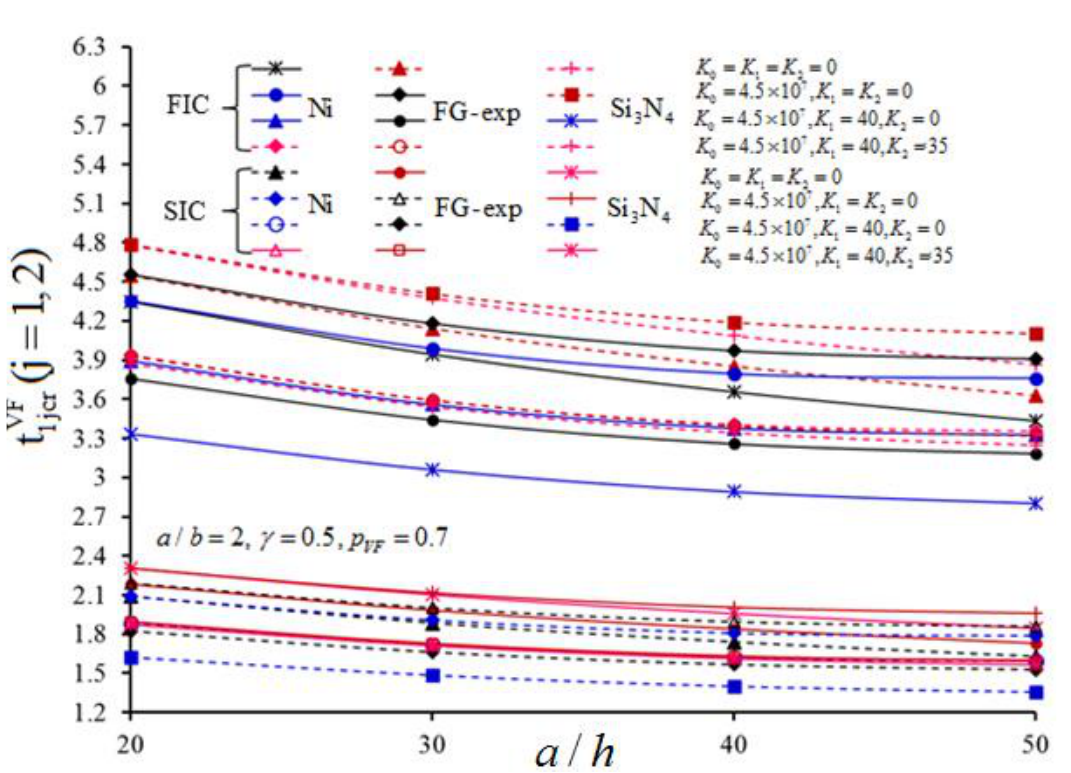
Figure 6. Changes of critical times of FG-VE-Ps on VE-Fs against a / h with FIC and SIC for various VE-Fs. The distributions of critical times of FG-VE-Ps on VE-Fs versus / ab for FIC and SIC are plotted in Figure 7. The data required for the numerical analysis are: 0 . 7 , 0 . 5 VF a / h = 50 , p = = and 6 2 . 51 0 , 4 0 , 30 K K K === . The influence of VE-F 0 12 (for 6 2 . 5 10 , 0 K K K === ) on the critical time decreases with increasing 012